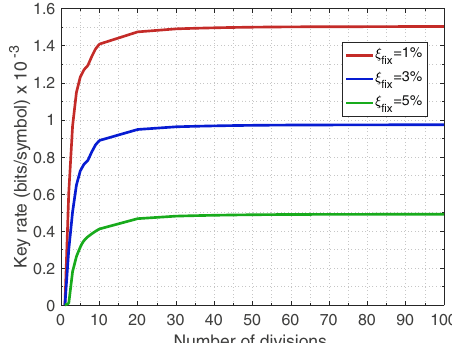
Fig. 6 Asymptotic key rate vs group factor. Secret key rate for channel subdivision from 1 to 100 equally spaced intervals for a